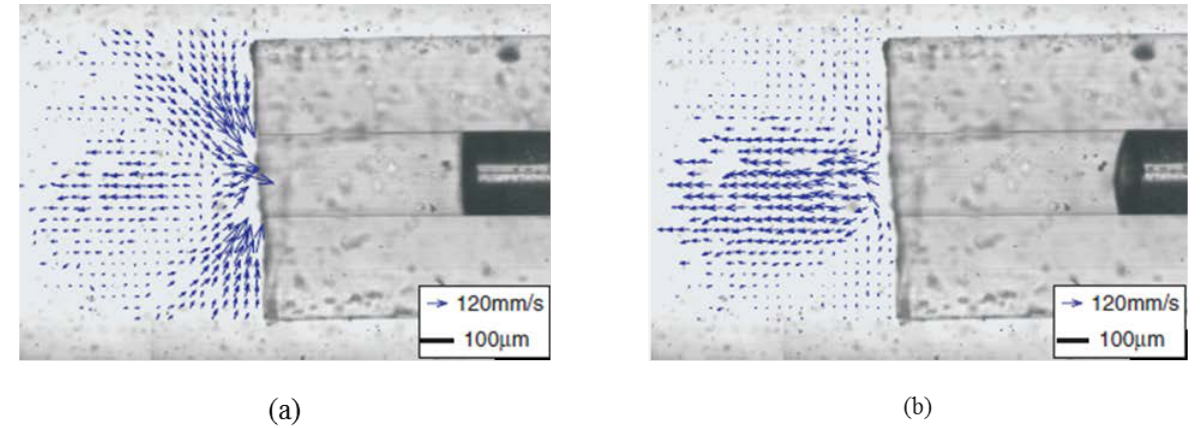
Figure 3. The flow field obtained from particle tracking velocimetry (PTV) at two phases of the acoustic cycle ( a ) phase 144